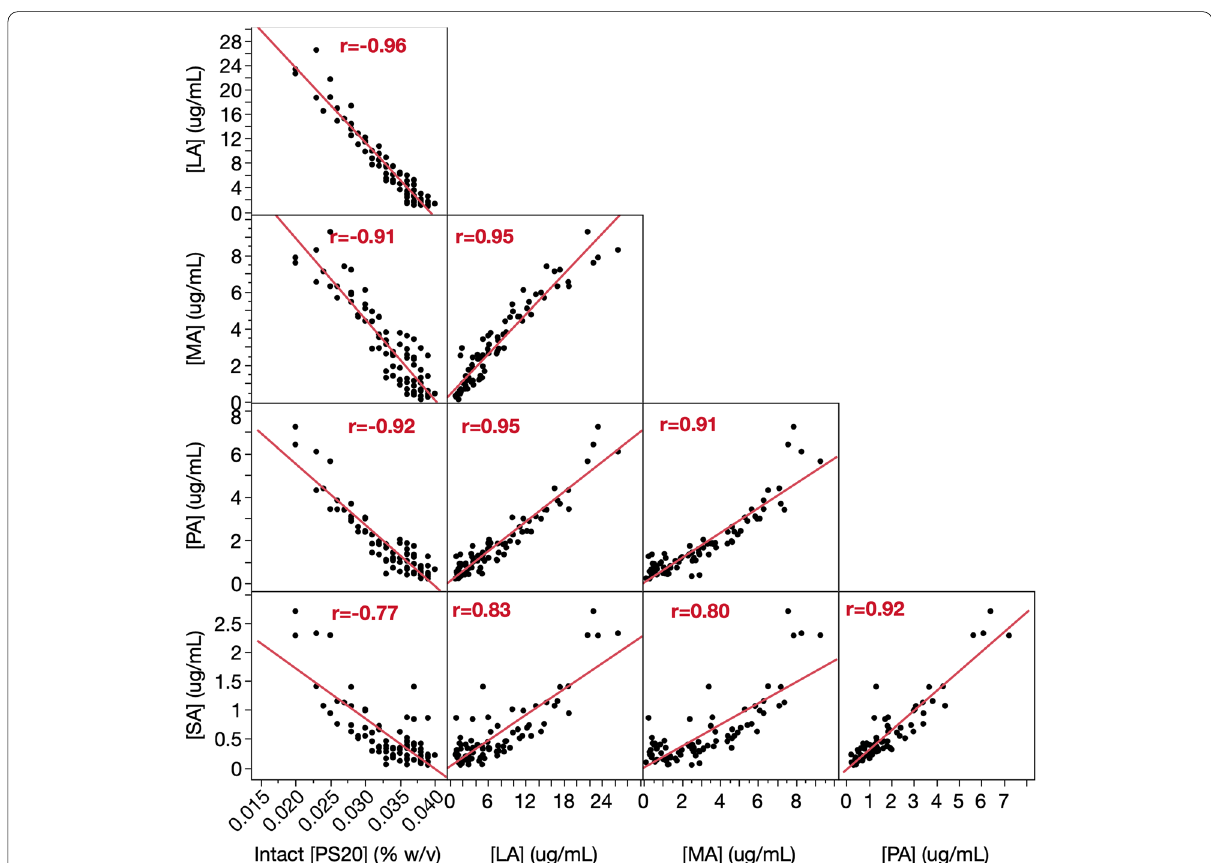
Fig. 11 Correlations between intact [PS20], [LA], [MA], [PA], and [SA] in mAb X DP formulations stored at 5 °C. Formulations shown here contain the same initial [PS20] (0.04% w/v) paired with unique combinations of [mAb] and pH. Intact PS20 was quantified by HPLC‑ELSD; FFAs were quantified by LC–MS. Correlation coefficient ( r ) values are shown within the scatterplot